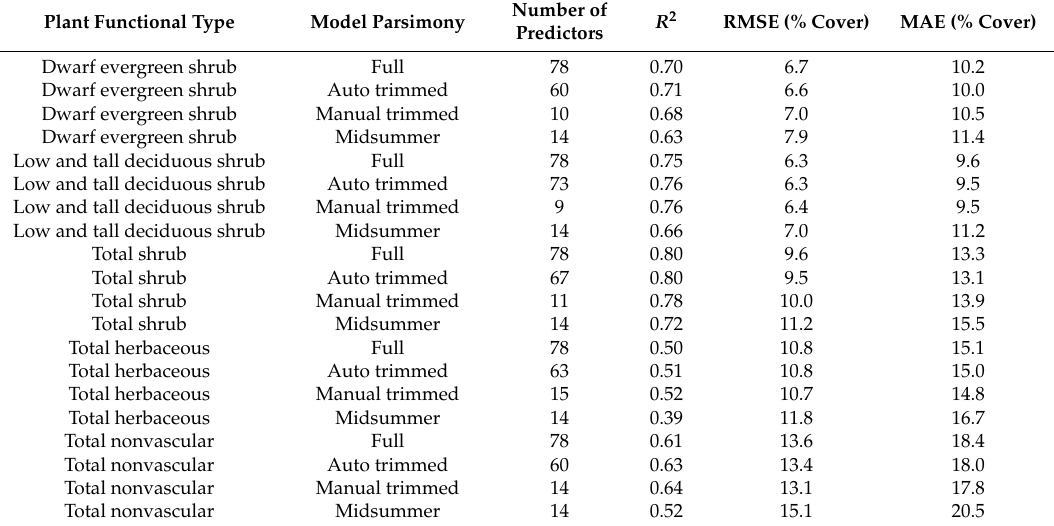
Table 6. Model performance metrics for selected cover models by plant functional type (PFT) at different levels of model parsimony, based on cross-validation, North Slope, Alaska. Bold numbers indicate the highest value for each performance metric within each PFT.